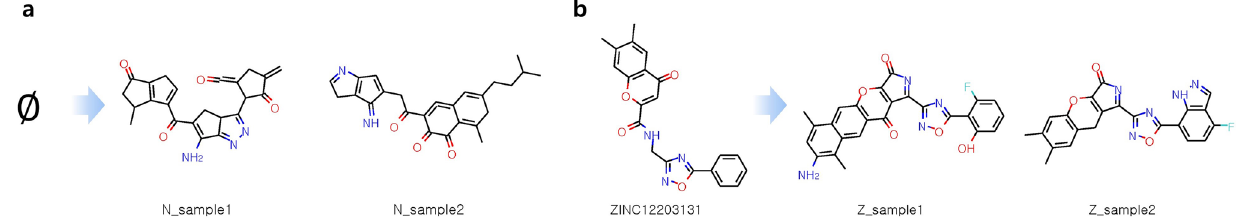
Figure 4. Samples from the inhibitors generated by the MORLD for the target D4DR. ( a ) Sample D4DR agonists generated from scratch (None). ( b ) Sample D4DR agonists generated from ZINC12203131, which was found by virtual screening.